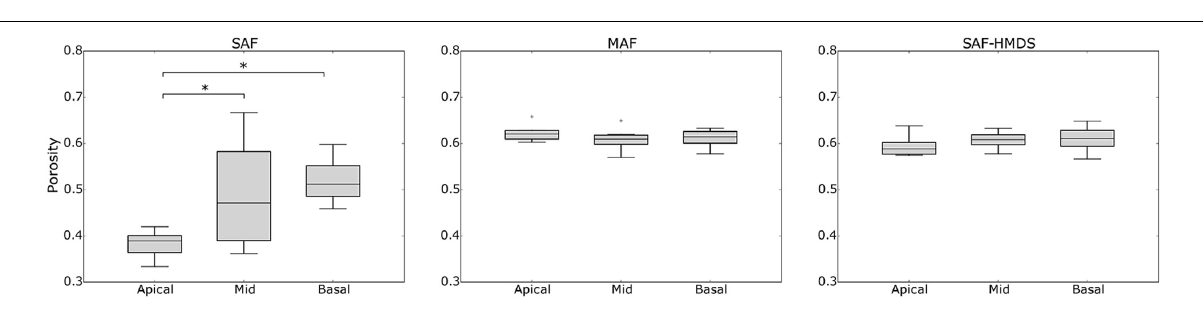
FIGURE 7 | Single-lung (Subject 1) analysis of variability of alveolar porosity in different anatomical sections in Subject 1. Nomenclature: ∗ p ≤